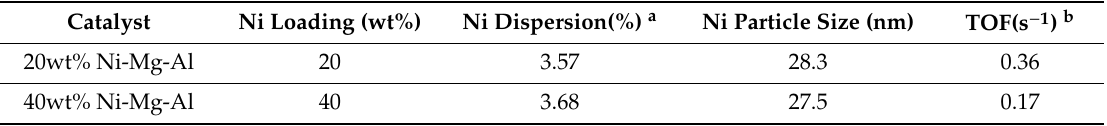
Table 3. Ni loading and dispersion of Ni-Mg-Al catalysts and their Turnover Frequency values based on CO 2 conversion.